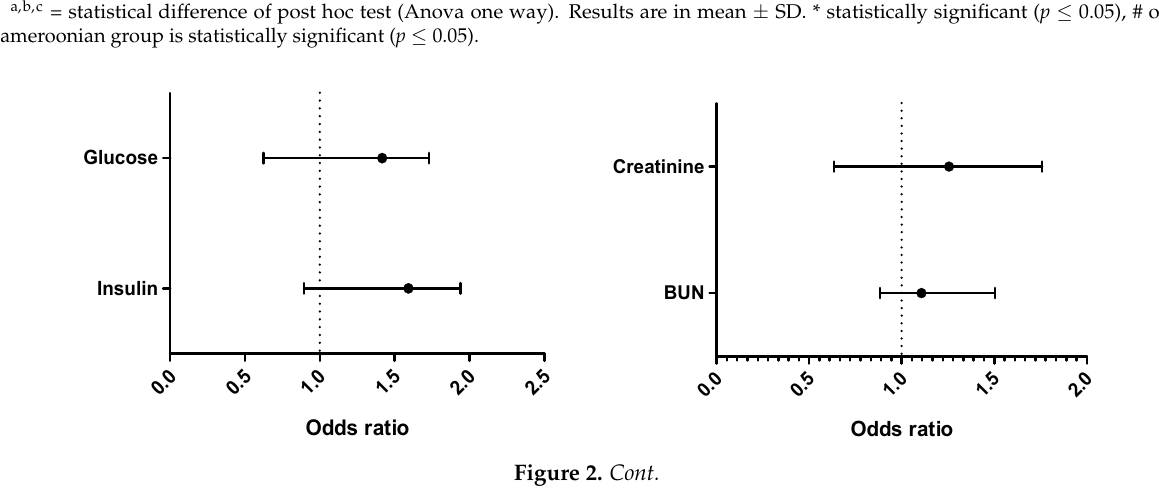
Odds ratio Figure 2. Binomial logistic regression (BLR) of all the biochemical parameters: Exposed Pakistan vs. exposed Cameroon (Tchosl = total cholesterol; HDL = high density lipoprotein; LDL = low density lipoprotein; Lp(a) = Lipoparticule a; AI = Arterogenic Index; BUN = Blood urea nitrogen; AST = aspartate transaminase; ALT = alanine transaminase; LDH = lactate deshydrogenase; GGT = gamma-glutamyl transferase; ALP = alkalin phosphatase; DBil = direct bilirubin; TBil = total bili- rubin). 3.4. Biochemical Tests: Hepatic Function Table 4 depicts the hepatic function in terms of biochemical tests. AST, ALT and LDH were noticeably raised ( p < 0.05) in both population groups, while Gamma glutamyl trans- ferase ( γ GT) was statistically different in the Cameroonian group only. Logistic regression (Figure 2) shows that ALP was 4 times and bilirubin was 3.06 times higher in the Pakistani than in the Cameroonian group. Table 4. Hepatic function variables in OPPs exposed and nonexposed groups in two populations . Pakistan